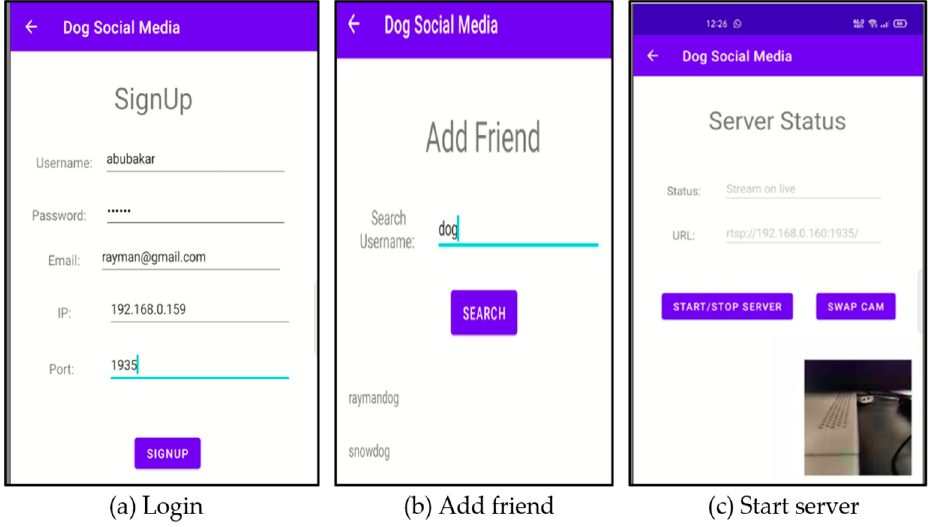
Figure 10. User interface of the developed dogs’ social network application: ( a ) login page of the application to set up live streaming, ( b ) add friend into the database, and ( c ) start the RTMP server.